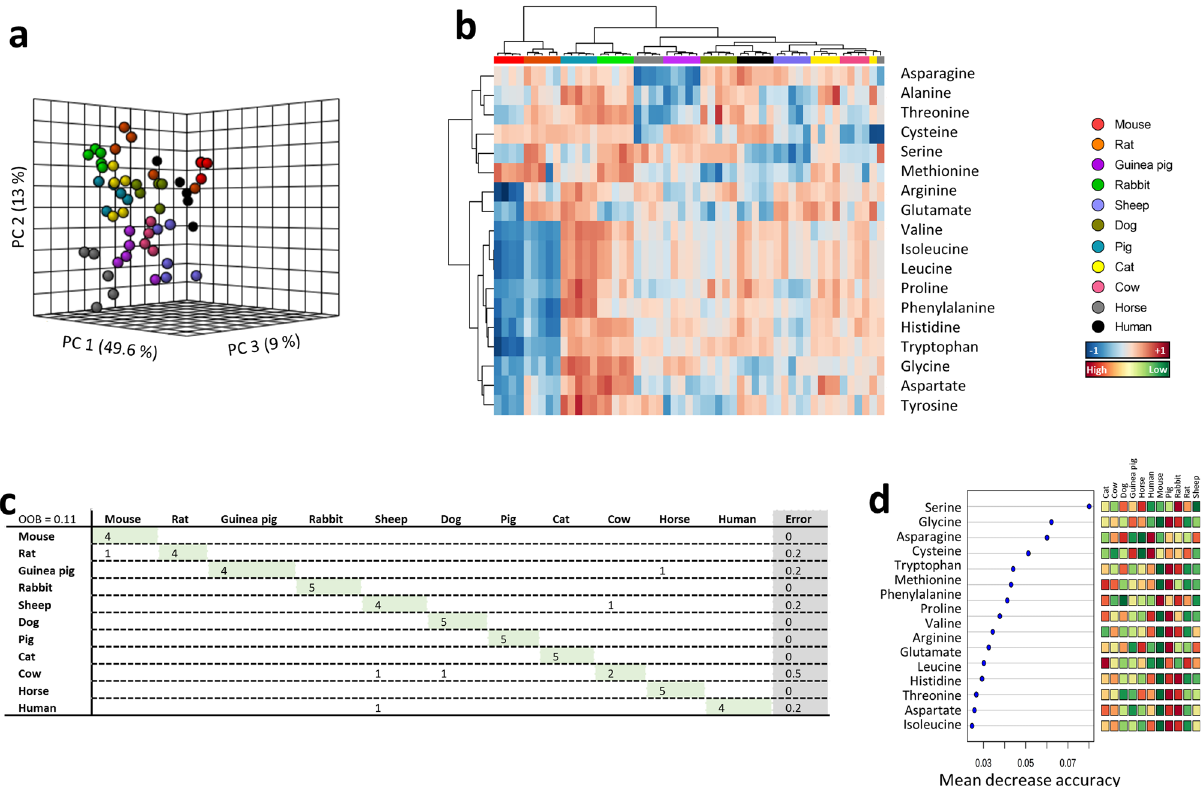
Fig. 3 Multivariate statistics reveals a species-speci fi c amino acids plasma pro fi le. a Principal component analyses (PCA) representation of amino acids. X: Principal component 1 (PC1); Y: Principal component 2 (PC2); Z: Principal component 3 (PC3). b Hierarchical clustering of individual animal samples according to metabolite abundance. c RF classi fi cation algorithm. d VIP scores for RF. Data values are obtained from four (mice and cows), fi ve (rats, rabbits, guinea pigs, sheep, dogs, pigs, cats and horses) or six (humans)